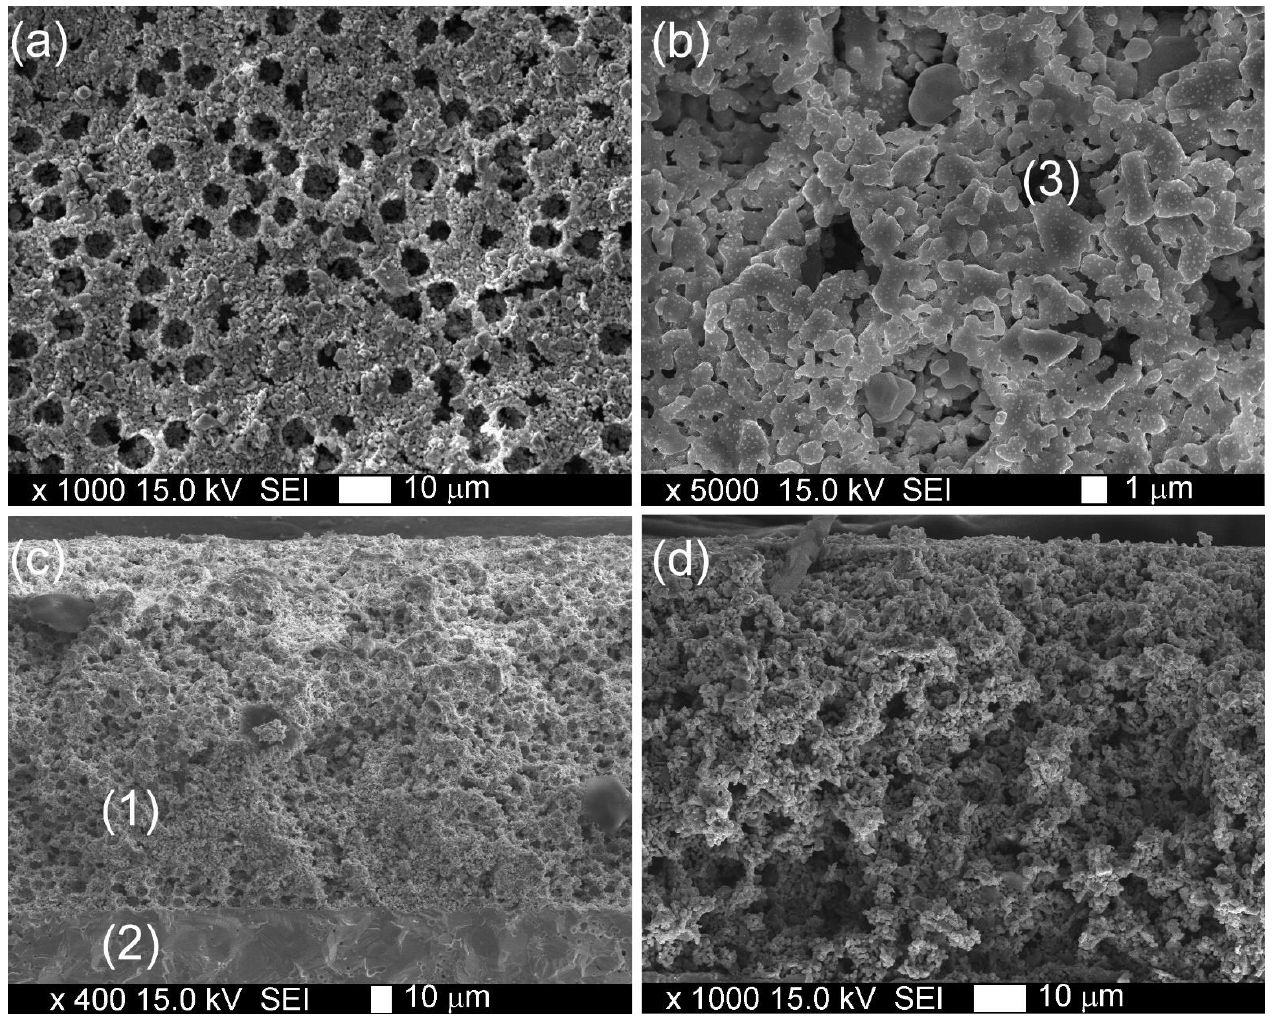
Figure 4. SEM images: ( a , b ) surface and ( c , d ) cross section of LSM1 electrode sintered at 1100 °C; (1) cathode, (2) electrolyte, and (3) pore formed by microbead.